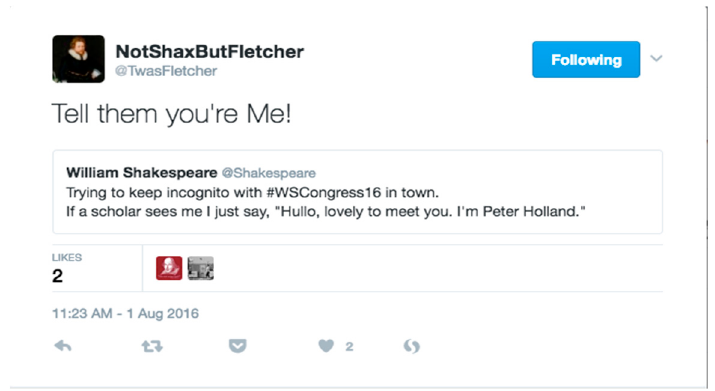
Figure 1. A Twitter interaction between @Shakespeare and @TwasFletcher, 1 August 2016.